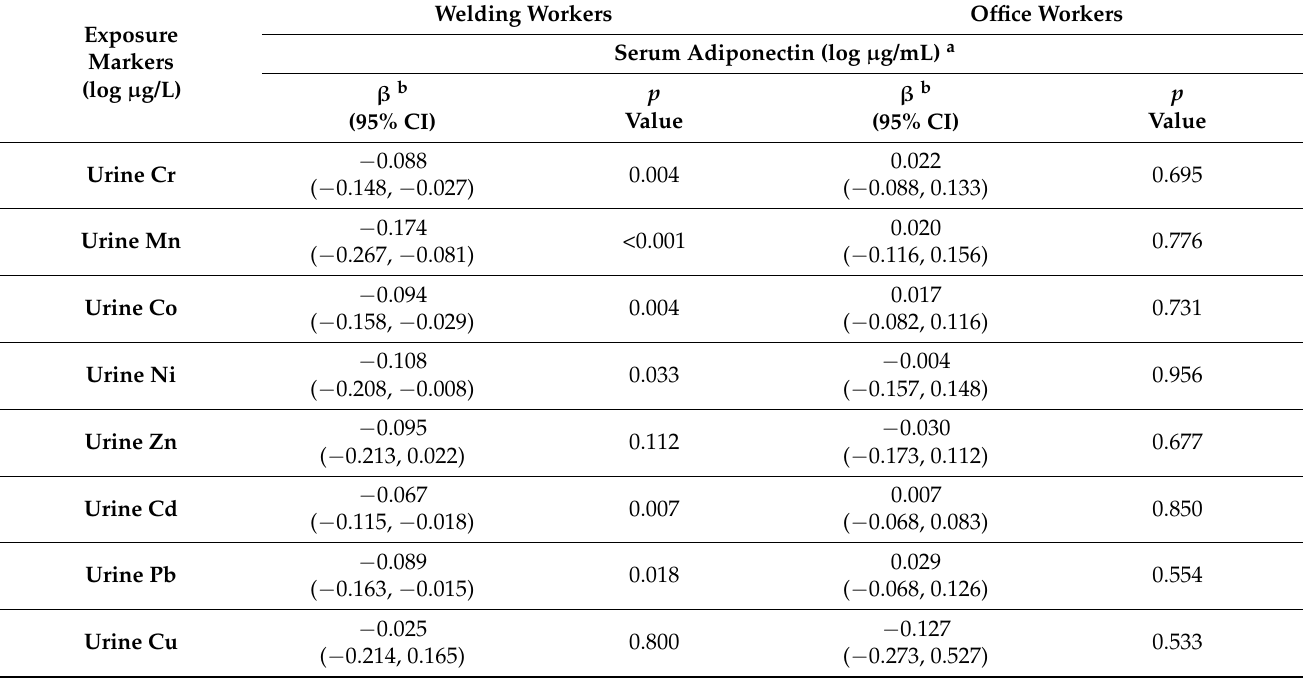
Table 3. Association between urinary metal concentrations and serum adiponectin levels by GEEs.